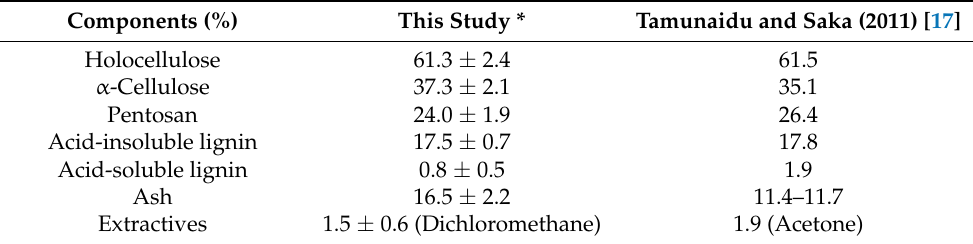
Table 1. Chemical composition of Nypa fruticans fronds used in this study and the literature.